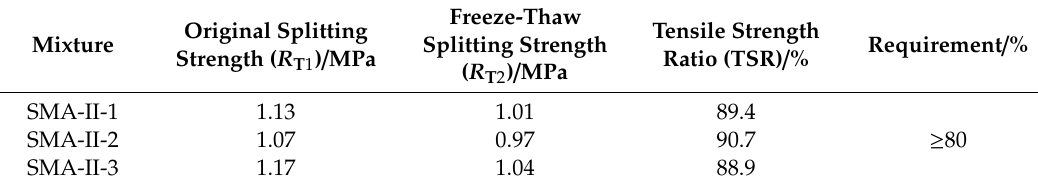
Table 17. Results of Freeze-thaw splitting test.